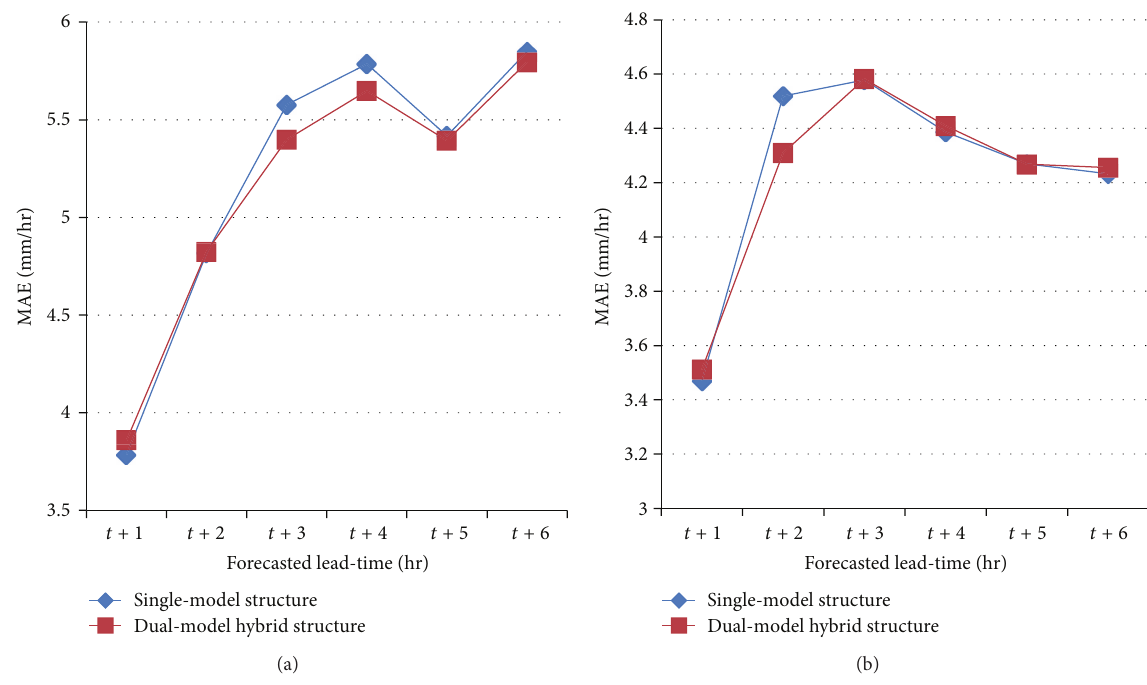
Figure 12: Comparison of the forecast performance of the single and hybrid BPNN-based models at Hsia-Yun station: (a) validation; (b)